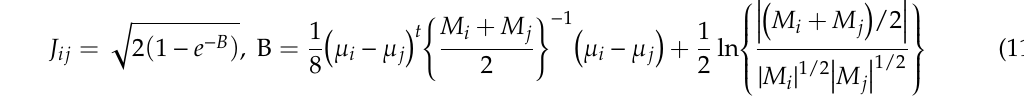
Figure 5. Land cover separabilities by Jeffreys-Matusita distances. It measured over simple phase coherence time series, PCA components (1 to 3) and k-PCA of HH1, HH2 HH3 and HH_HV packets.